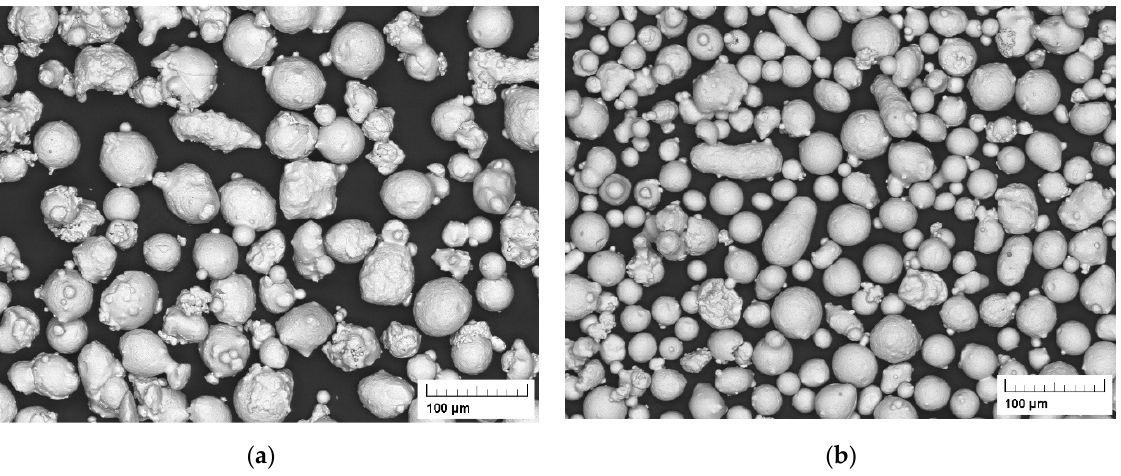
Figure 2. SEM images of particle morphology of the initial powders: ( a ) X2CrNiMo17 ‐ 12 ‐ 2; ( b ) X2CrNiMoN25 ‐ 7 ‐ 4.